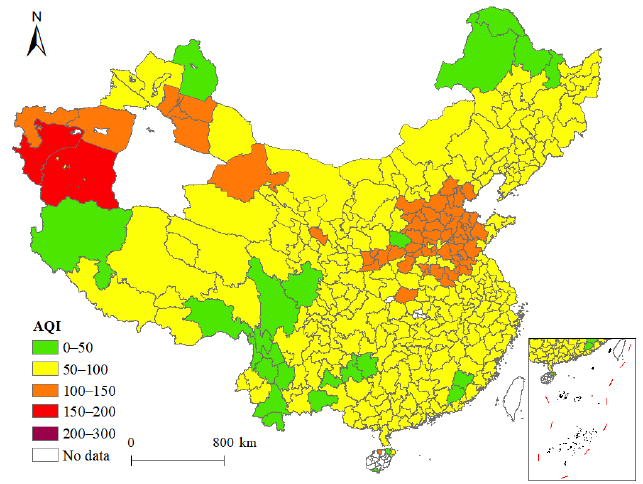
Figure 1. Spatial distribution of AQI of cities in 2017.